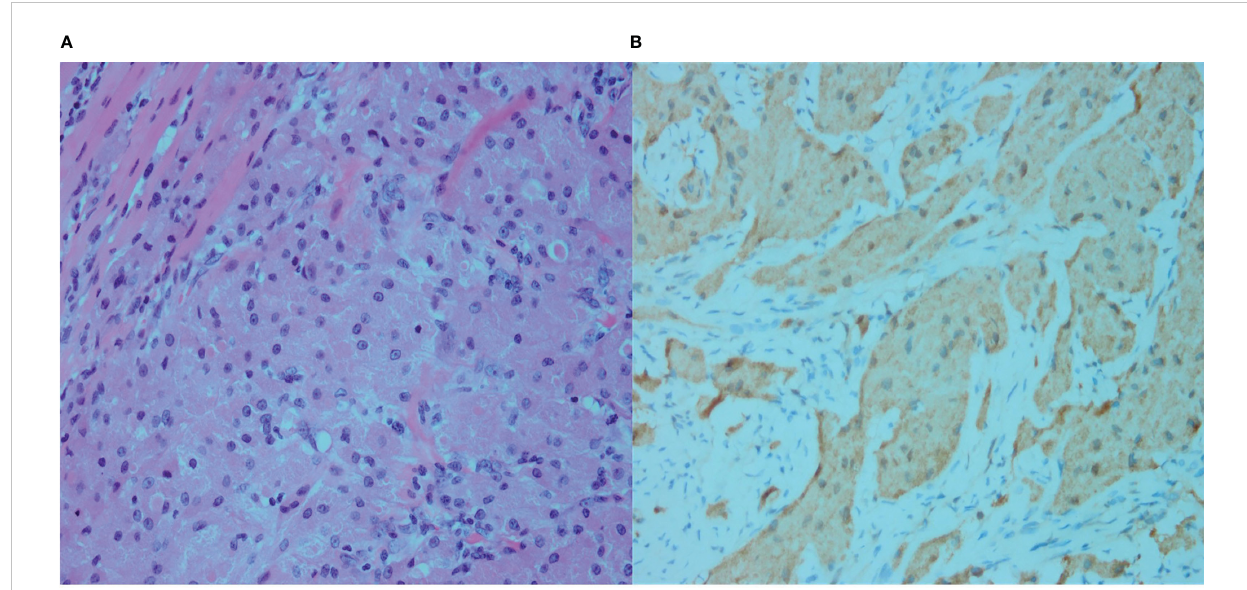
FIGURE 2 (A) Microscopy showing dense granular cells that are diffusely distributed, as well as in fi ltration and growth of the granular cells between the muscle fi bers, with no clear separation between the cells and the muscle fi bers (Hematoxylin and eosin [H&E] staining, ×400). (B) S-100. The cytoplasm of the tumor cells is brownish yellow, indicating strong positive staining (immunostaining, ×400).